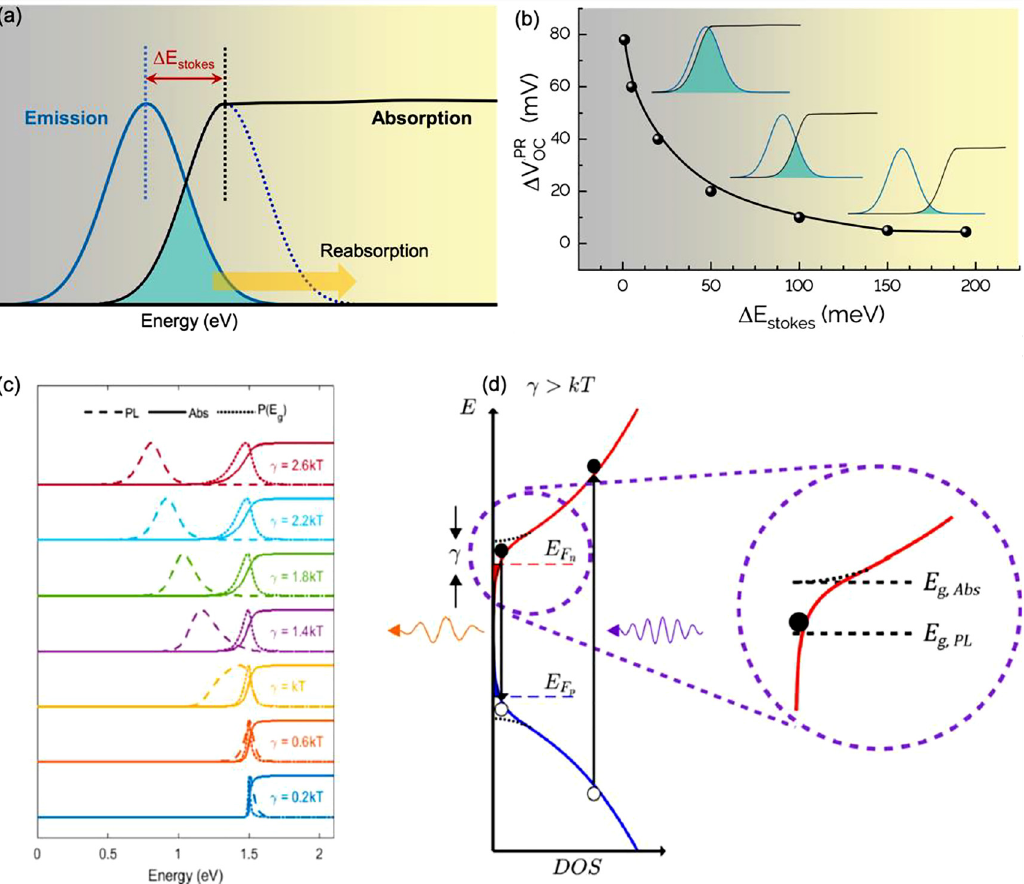
Figure4: (a)Schematicdiagramrepresentingemission,absorption,reabsorptionspectra,andStokesshift( Δ E stokes ).Theoverlapisessential between emission and absorption spectra as it increases the reabsorption and consequently enhances the Δ V PR function of ( Δ E stokes ) in perovskite fi lms. The table shows the Stokes shift in GaAs and perovskites, as reported in the literature. (c) Effects of Urbachenergy( γ )onabsorptionandemission(photoluminescence)spectrum;Normalizedphotoluminescence(PL,dashedline),absorptance (Abs, solid line) spectrumanddistributionof band gaps(dotted line)of solar cell with increasing γ . (d) Schematic diagram of density of states (DOS) with excitation and recombination of carrier. Figure (a) – (b) are derived from Ref. [12] and Figure (c) – (d) are taken with permission from Ref. [60].